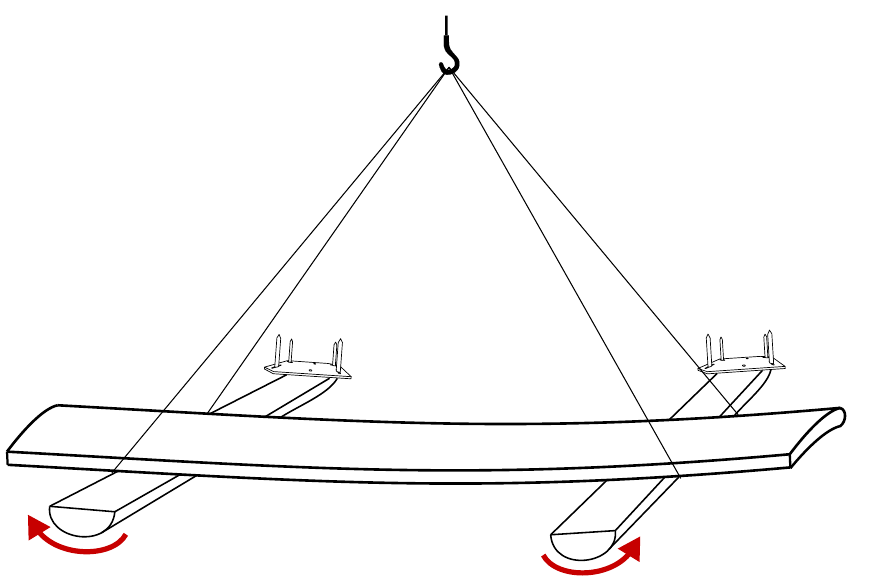
Figure 4. Flap distortion by own weight while lifting it with a crane.